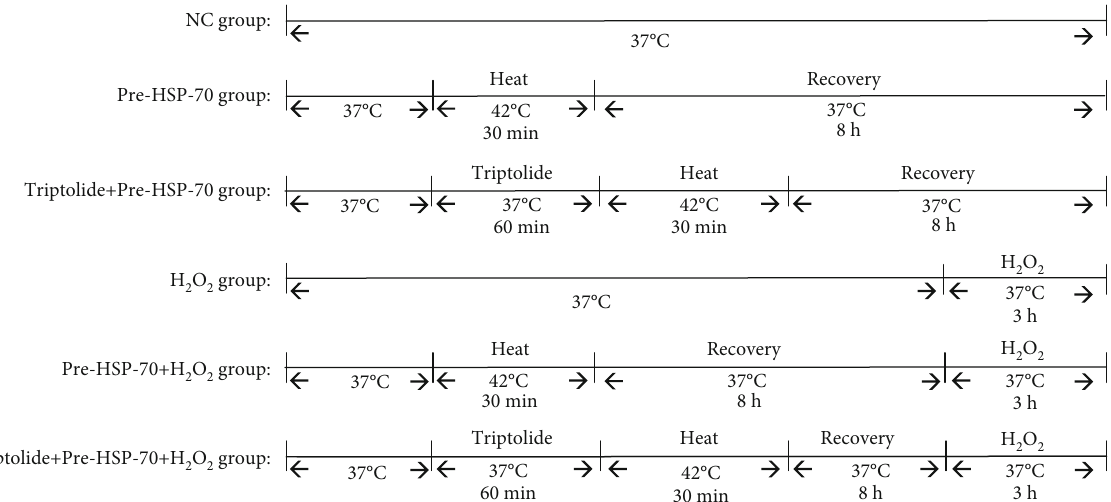
Figure 1: Experimental groups. NC group: the cells were kept in a 37 ° C in humid air with 5% CO Pre-HSP-70 group: the cells were kept in a 42 ° C in humid air with 5% CO treated with triptolide 1 h before heat shock preconditioning. H group: the cells were treated with triptolide 1 h before